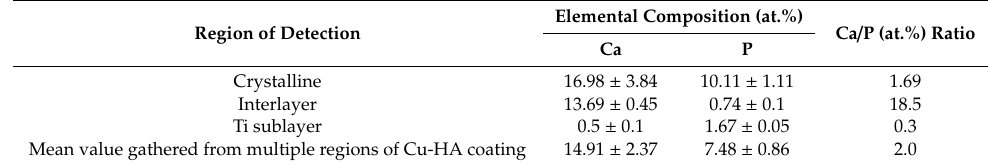
Figure 8. An energy dispersive X-ray (EDX) element mapping of the Cu-HA and Ti substrate in TEM lamella. ( a ) ROI in STEM; ( b ) P Ka1; ( c ) Ca Ka1; ( d ) Cu Ka1; ( e ) O Ka1; ( f ) Ti Ka1.